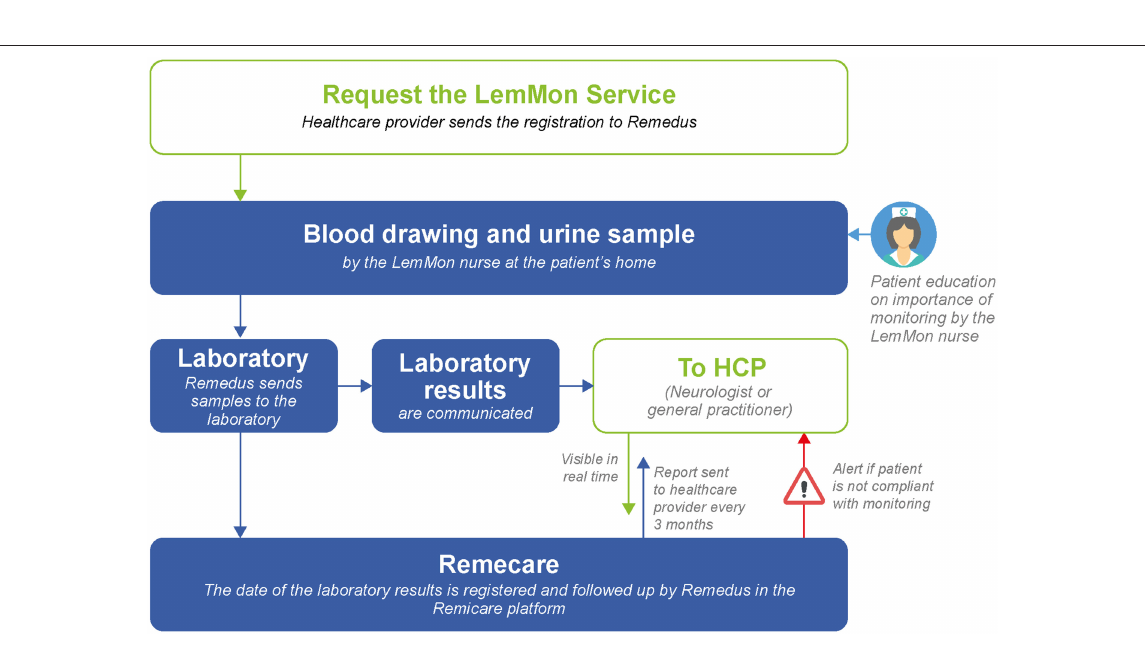
FIGURE 3 | The Remedus data management